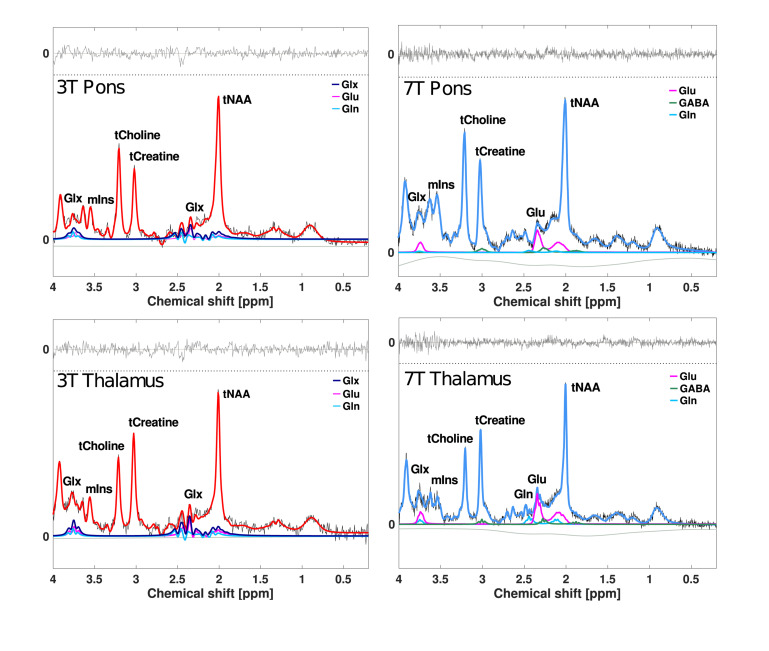
Examples of 1H-MR spectra from pons and thalamus. All lines represent the LCModel fits. Red lines represent the overall fit at 3T, and blue lines represent the overall fit at 7T. Purple, pink, light blue, and green lines represent fits for Glx, glutamate, glutamine, and GABA. Baselines are visualized as lower horizontal wavy gray lines in all spectra. Residual fits are presented as upper horizontal gray lines. SNR and FWHM of 3T example spectra are 20 and 0.03 ppm in pons and 17 and 0.03 in thalamus. SNR and FWHM of 7T example spectra are 25 and 0.04 ppm in pons and 25 and 0.03 in thalamus. Glx, glutamate + glutamine; Glu, glutamate; Gln, glutamine; GABA, γ-aminobutyric acid; tNAA, N-acetylaspartate + N-acetylaspartyl glutamate; tCreatine, creatine + phosphocreatine; tCholine, glycerophosphocholine + phosphocholine; mIns, myo-inositol; SNR, signal-to-noise ratio; FWHM, full-width of half-maximum, linewidth.